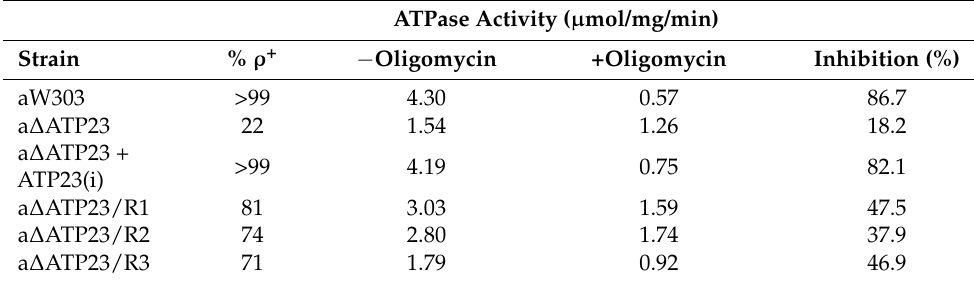
Figure 1. Growth properties and subunit 6 expression of atp23 revertants. ( A ) Serial dilutions wild-type strain aW303, atp23 null mutant (a ∆ ATP23), atp23 null mutant expressing chromosomally integrated copy of ATP23 [a ∆ ATP23 + ATP23(i)], and three revertants (a ∆ ATP23/R1, a ∆ ATP23/R2, a ∆ ATP23/R3) were spotted on YPD (rich glucose) and YPEG (rich ethanol/glycerol) plates. Images were taken after growth for 2 days at 30 ◦ C. ( B ) Western blot analysis of mitochondrial β subunit of F 1 (F 1 - β ) and Atp6 of Fo. Mitochondria (40 µ g) prepared from same strains shown in ( A ) were analyzed by SDS-PAGE and immunoblotted with antibodies against F 1 - β , Atp6, and VDAC1. VDAC1 was used as a loading control. ( C ) In vivo labeling of newly synthesized mitochondrial translation products of revertants. Mitochondrial translation products in the same strains shown in ( A ) were labeled with [ 35 S]-methionine in the presence of cycloheximide. The labeled mitochondrial translation products identified in the margin are ribosomal protein Var1, subunit 1 (Cox1), subunit 2 (Cox2), subunit 3 (Cox3) of cytochrome oxidase, cytochrome b (Cyt.b), and subunit 6 (mAtp6), subunit 8 (Atp8), and subunit 9 (Atp9) of ATPase. Precursor form of subunit 6 (pAtp6p) seen in the null mutant and revertants migrated slightly higher than the mature protein (mAtp6). Table 1. Mitochondrial ATPase activity and oligomycin sensitivity of